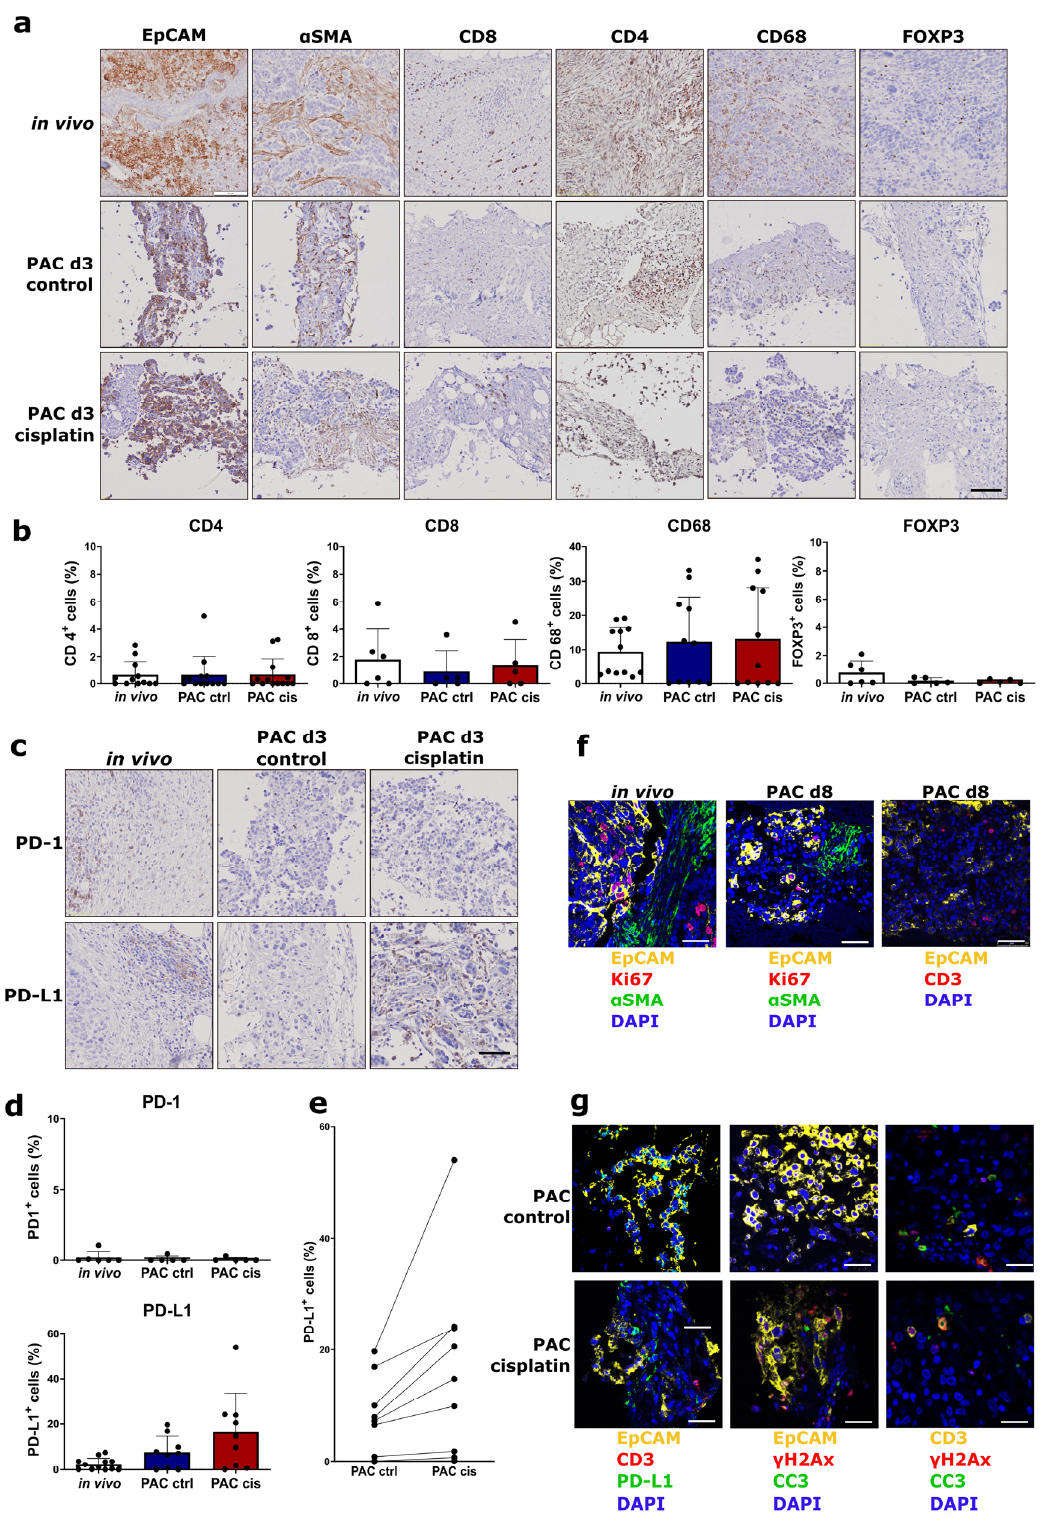
Figure 10. The tumor microenvironment including immune cells are preserved in tumor slice culture in the PAC system. The primary human ovarian tumor slices were cultured in the perfusion air culture (PAC) system without (ctrl) or with cisplatin (cis) treatment for 3 days. ( a ) Immunohistochemical (IHC) staining of biomarkers expression for tumor cells (EpCAM), fibroblasts (aSMA), T cells (CD4, CD8, and FOXP3), and macrophages (CD68) in tumor slices compared to the in vivo tumors. The scale bar represents 100 µm. ( b ) Percentage of CD4-, CD8-,